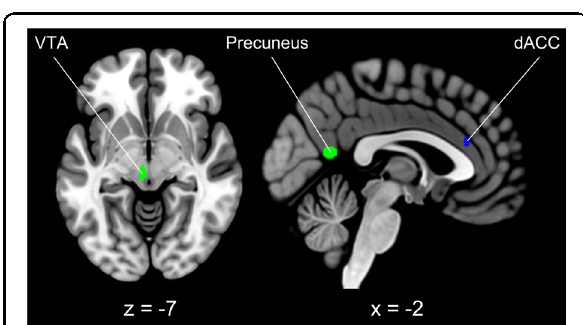
Fig. 2 Results of the binomial CCA for the factor “ treatment status ” . Clusters speci fi c for treatment-seeking individuals are depicted in green, whereas the cluster speci fi c for not-seeking treatment subjects is depicted in blue. The decoder function of Neurosynth returned the following 15 terms with the highest association with the CCA map (decreasing order): aversive, reversal (learning), anticipatory, heart (rate), intense (emotion), episodic memory, autobiographical, cognitive emotional, force, fear, reward, mild cognitive, pain, personal, sensation. Slice coordinates are reported in MNI stereotaxic space. dACC dorsal anterior cingulate